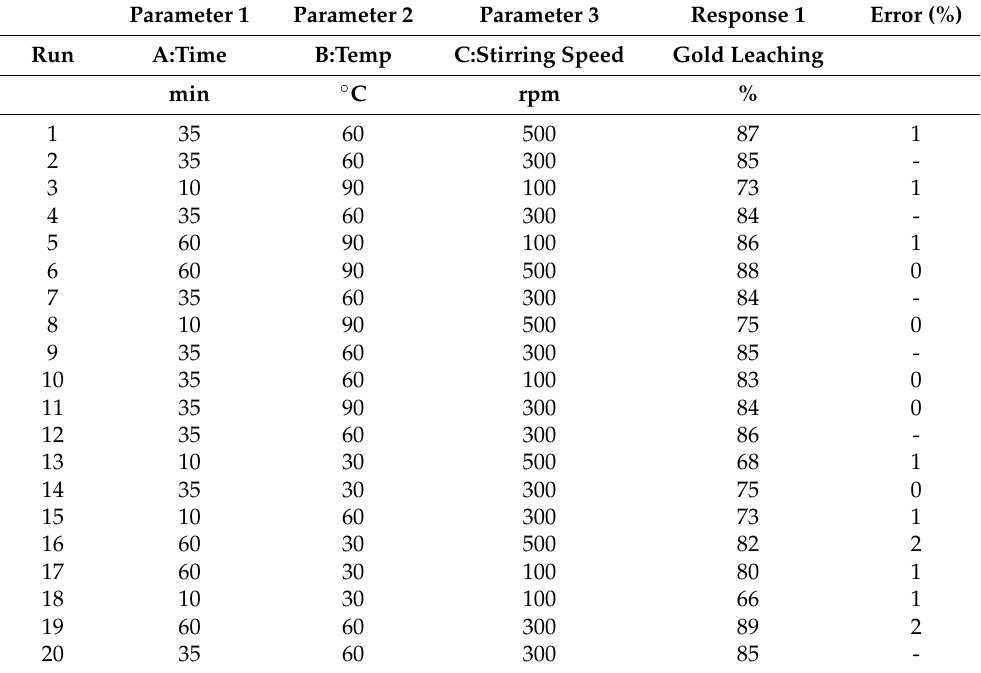
Table 3. Central composite design layout adopted in the present work for the leaching of